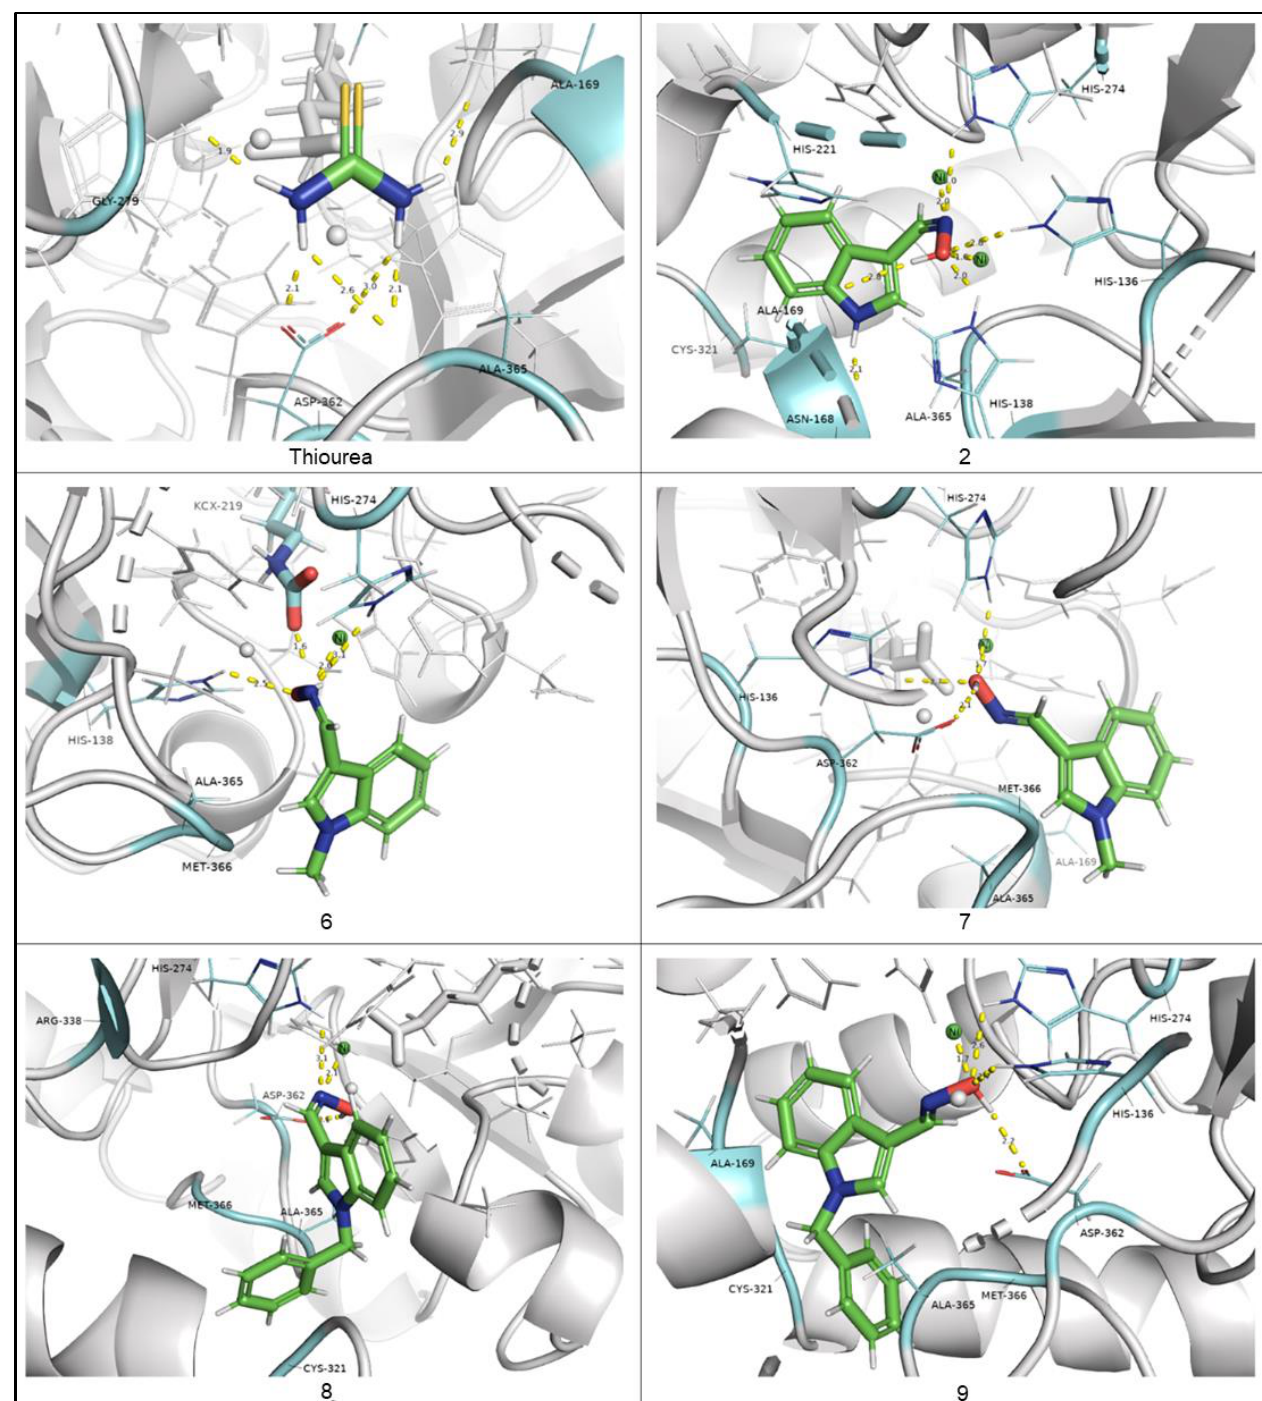
Figure 2. Protein – ligand interaction of the oxime compounds in the active site of the urease enzyme via PyMOL 3D visualizer.